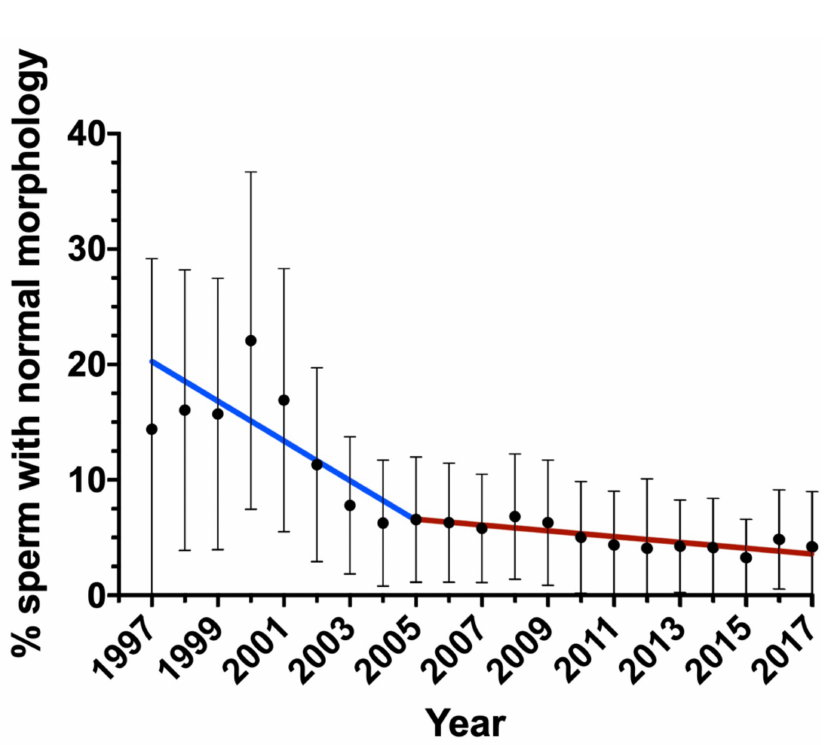
Figure 1. Change in the percentage of sperm with normal morphology during the period of study. Bars indicate standard